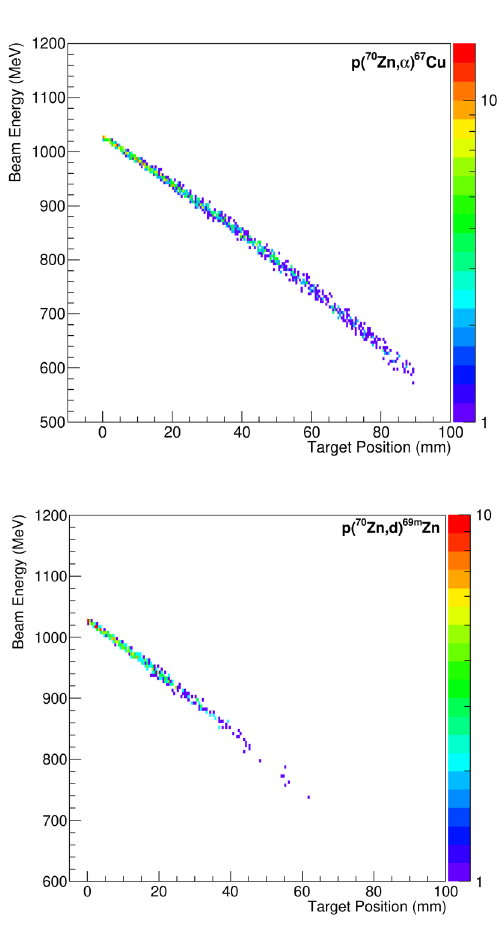
Fig. 4. (Color online) Beam energy as a function of reaction position on the gas target for the reactions p( 70 Zn, 67 Cu) α (upper part) and p( 70 Zn, 69m Zn) α (lower part) according to GEANT simulation